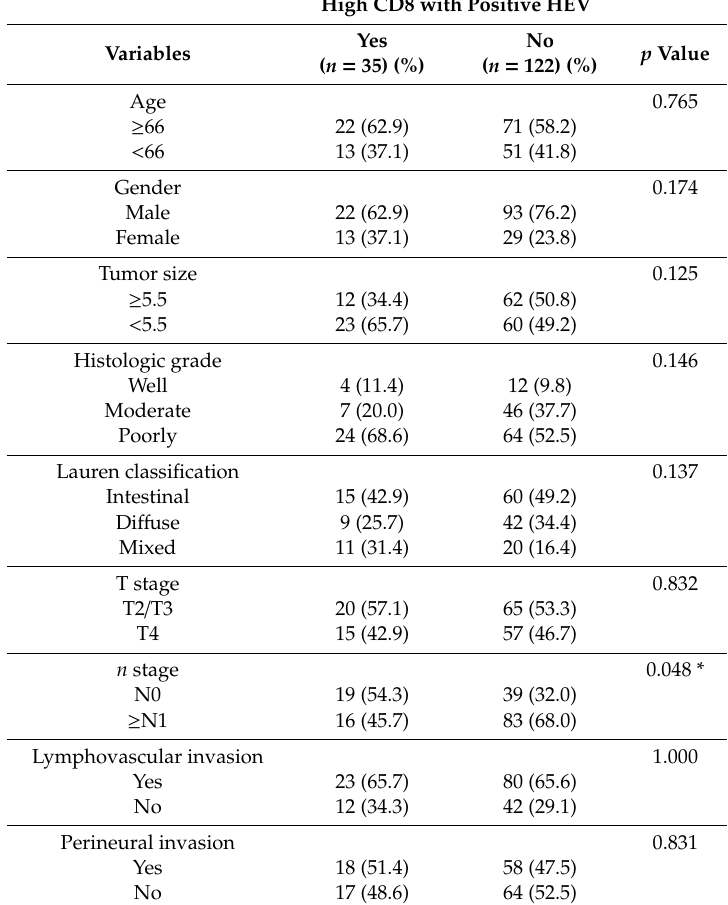
Table 2. Association between a high CD8 level with a positive HEV level and a clinicopathologic finding of advanced gastric cancer.